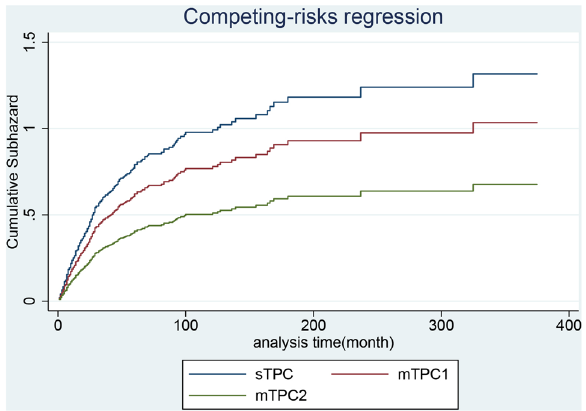
Figure 5. For breast cancer with prior lung cancer, adjusted cumulative hazard of cancer-specific mortality since secondary cancer was classified into group sTPC, mTPC1 and